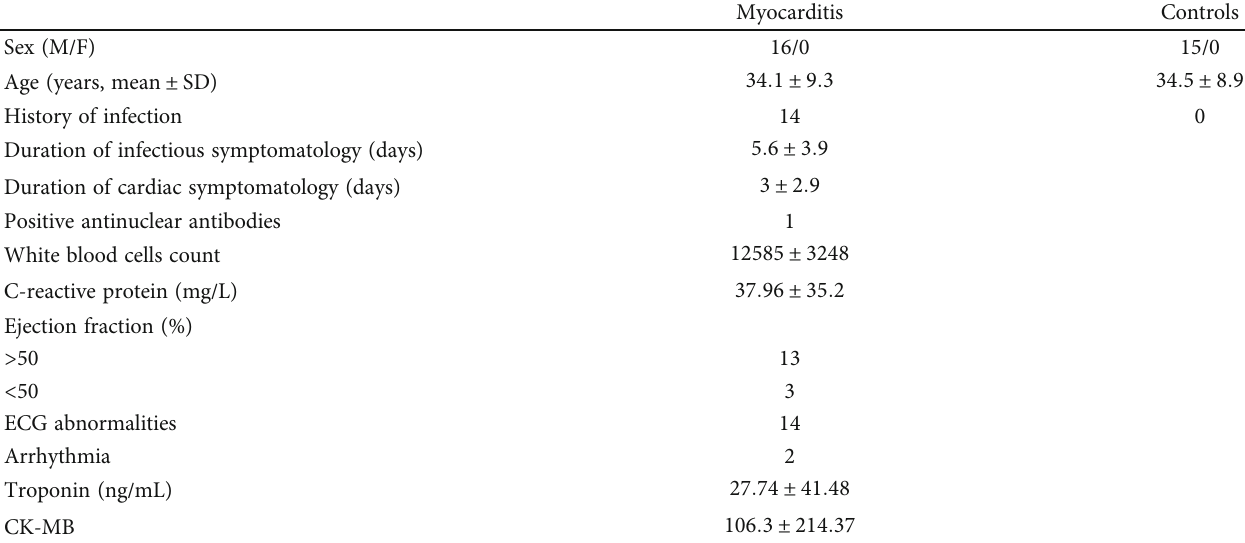
Table 1: Clinical characteristics of patients with